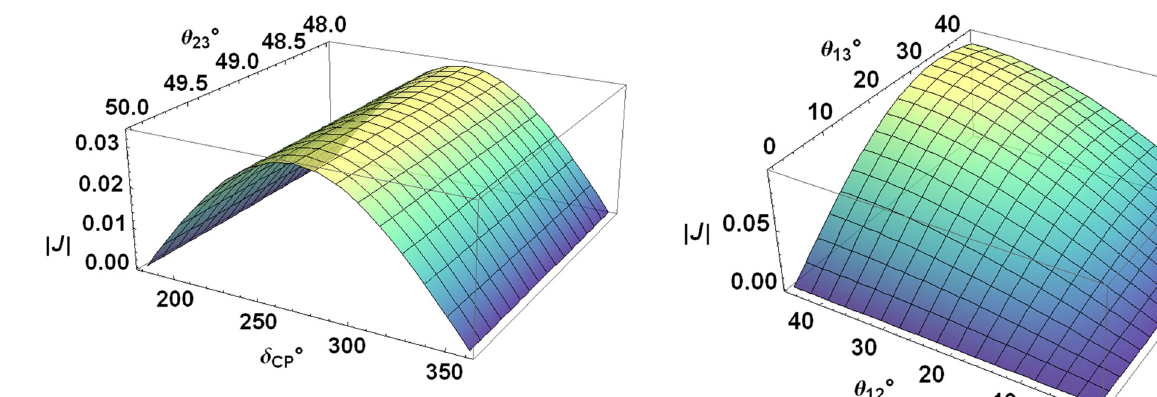
Fig. 2 Dependence of the absolute value of the Jarlskog invariant J on θ δ CP for neutrinos in the standard parameterization with account 23 and for the experimental data [39]